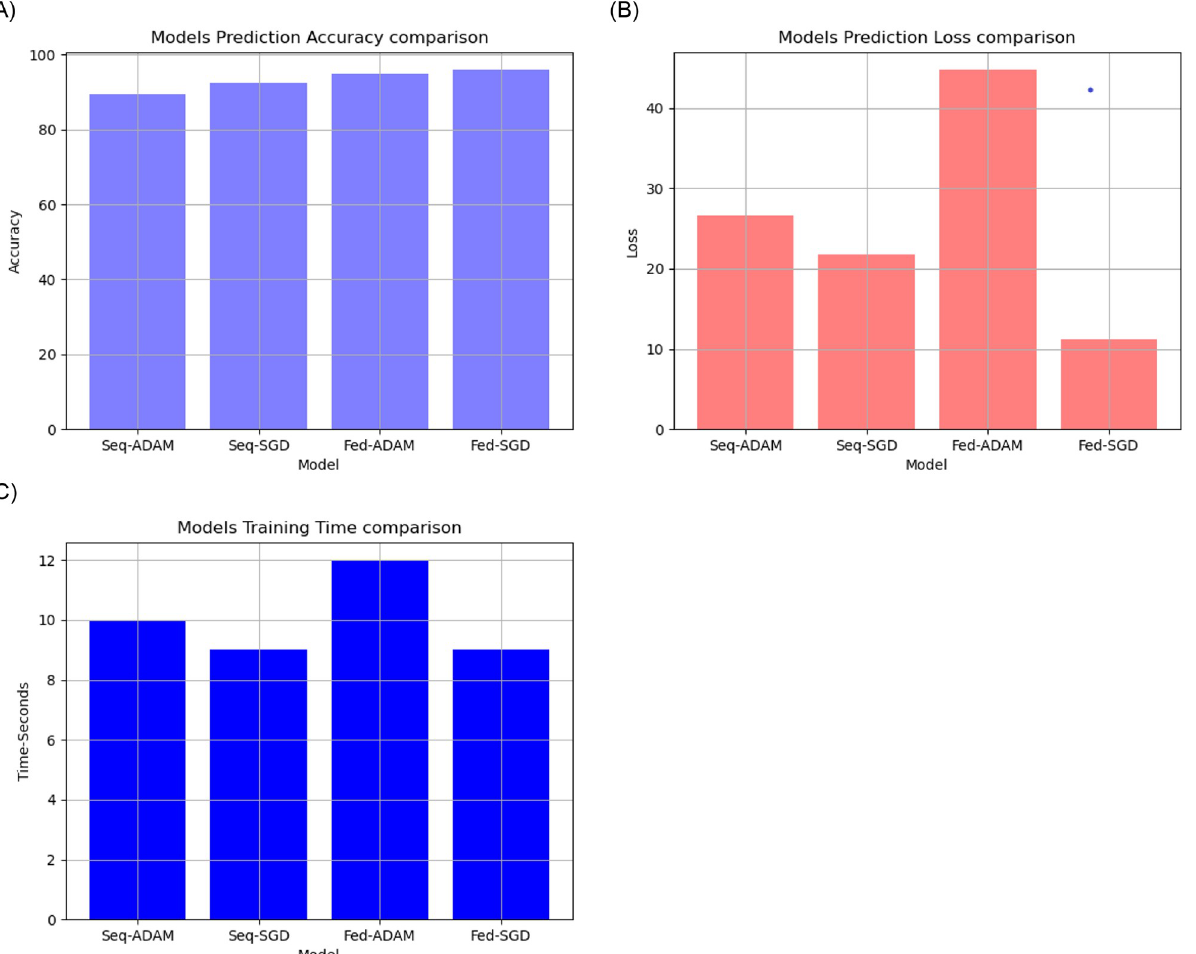
Fig 8. Model accuracy, loss and time comparison on patient’s chest x-rays dataset.